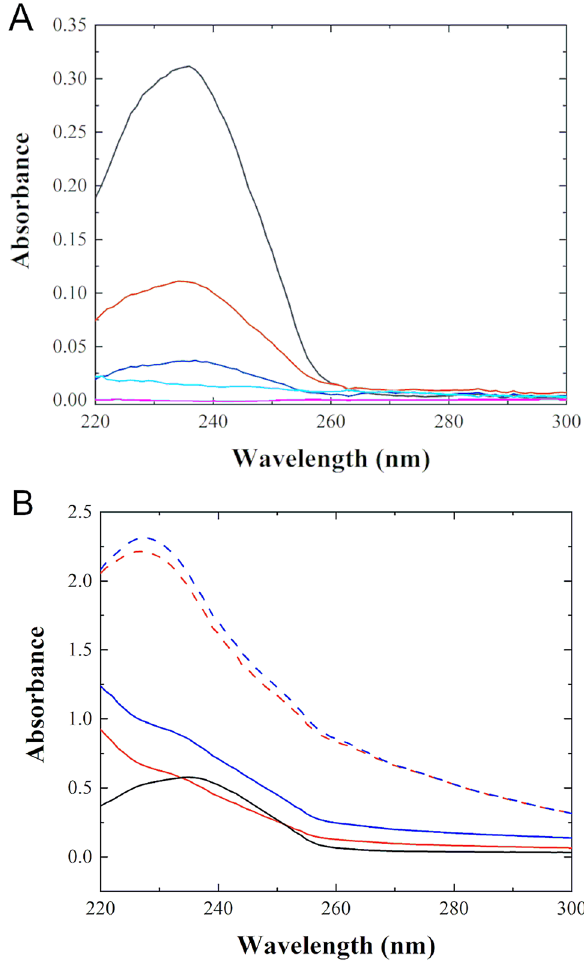
Figure 7. Absorbance measurements from vesicles containing a polyunsaturated lipid exposed to Cu 2+ and piscidin bound to Cu 2+ . SUVs made of 3:1 DLPC/POPG were prepared and exposed to different forms and amounts of Cu 2+ and measured by UV spectrophotometry after 24 h of exposure. ( A ) Samples containing SUVs at a fixed lipid concentration of 0.50 mg/mL (640 µmol/L) were mixed with various amounts of CuCl 2 , as follows: Cu 2+ /L = 1:2 molar ratio (black), Cu 2+ /L = 1:8 (red), Cu 2+ /L = 1:32 (blue), BHT/L = 1:100, and Cu 2+ /L = 1:8 (cyan) and lipid alone (magenta). ( B ) SUVs at a concentration of 0.20 mg/mL (260 µmol/L) were studied in the presence of the peptides at P/L = 1:10, corresponding to a peptide-Cu 2+ complex concentration of 26 µmol/L. P1-Cu 2+ (blue, dashed); P3- Cu 2+ (red, dashed); P1 (blue); P3 (red); lipid alone (black). The source of free Cu 2+ (CuCl 2 ) was the same as that used for metallating P1 and P3. Measurements were taken in triplicates at 24 h after exposure. The spectra were corrected for the background signals from CuCl 2 and the lipids at time zero as explained in the Methods. Uncertainties are smaller than the line thicknesses. Strong absorbance at 234 nm after 24 h of exposure points at the formation of lipid oxidation products, a result confirmed by mass spectrometry (Fig.